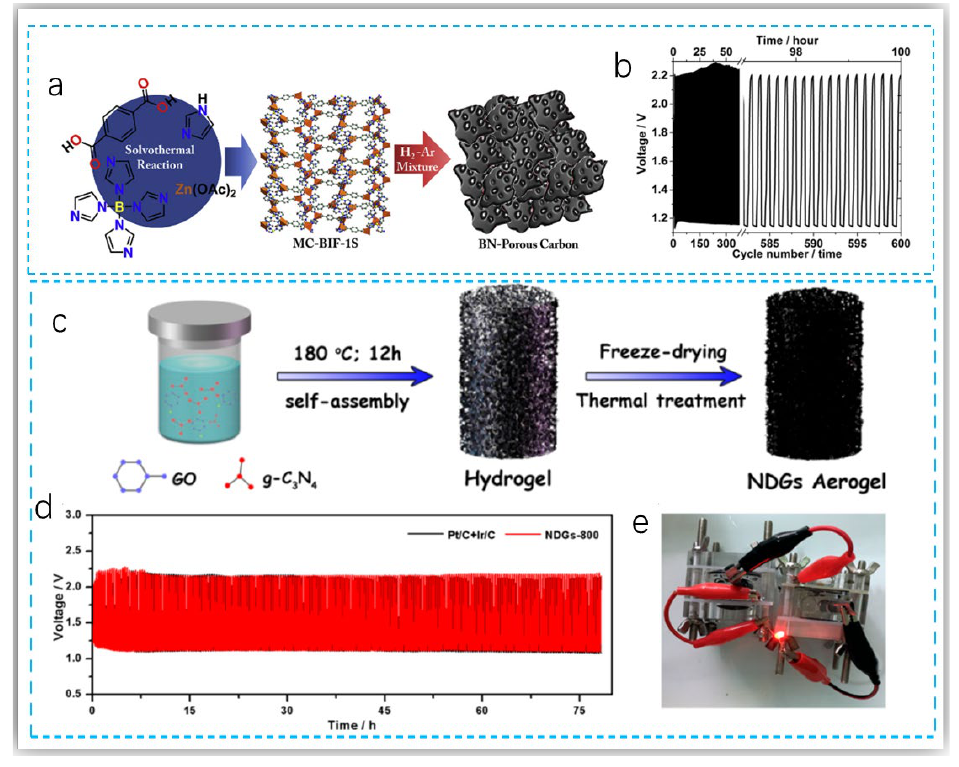
Figure 9. ( a ) The synthetic scheme of BNPCs [92], reprinted with permission from Ref. [92]. Copyright © 2016 Elsevier Ltd. ( b ) Cycling performance of the rechargeable Zn–air battery using BNPC-1100 as the air cathode. A cycle consists of a discharging stage and a charging stage for 300 s respectively at 2 mA · cm − 2 [92]. ( c ) Schematic illustration of the fabrication process series of samples [93], ( d ) Charge-discharge cycling performance of rechargeable Zn–air batteries at a constant charge-discharge current density of 10 mA · cm − 2 [93], ( e ) Photograph of a two-series liquid Zn–air red LED light ( ≈ 3.0 V) [93]. Reprinted with permission from Ref. [93]. Copyright © 2018 American Chemical Society.